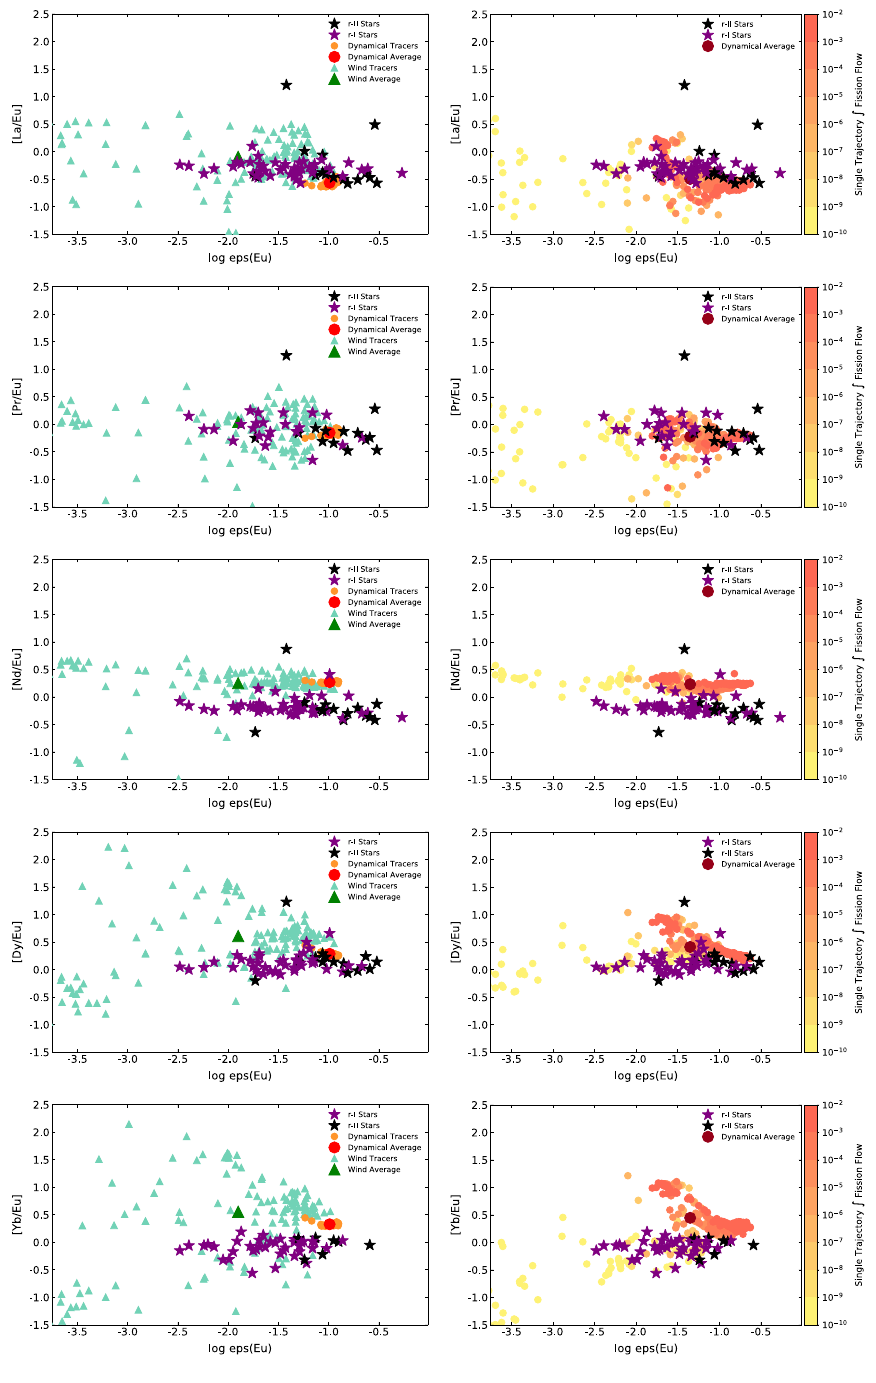
Figure 6. Same as Fig. 5 but for lanthanide species (La, Pr, Nd, Dy, and Yb) relative to another lanthanide element, Eu (a subset of such plots was shown in